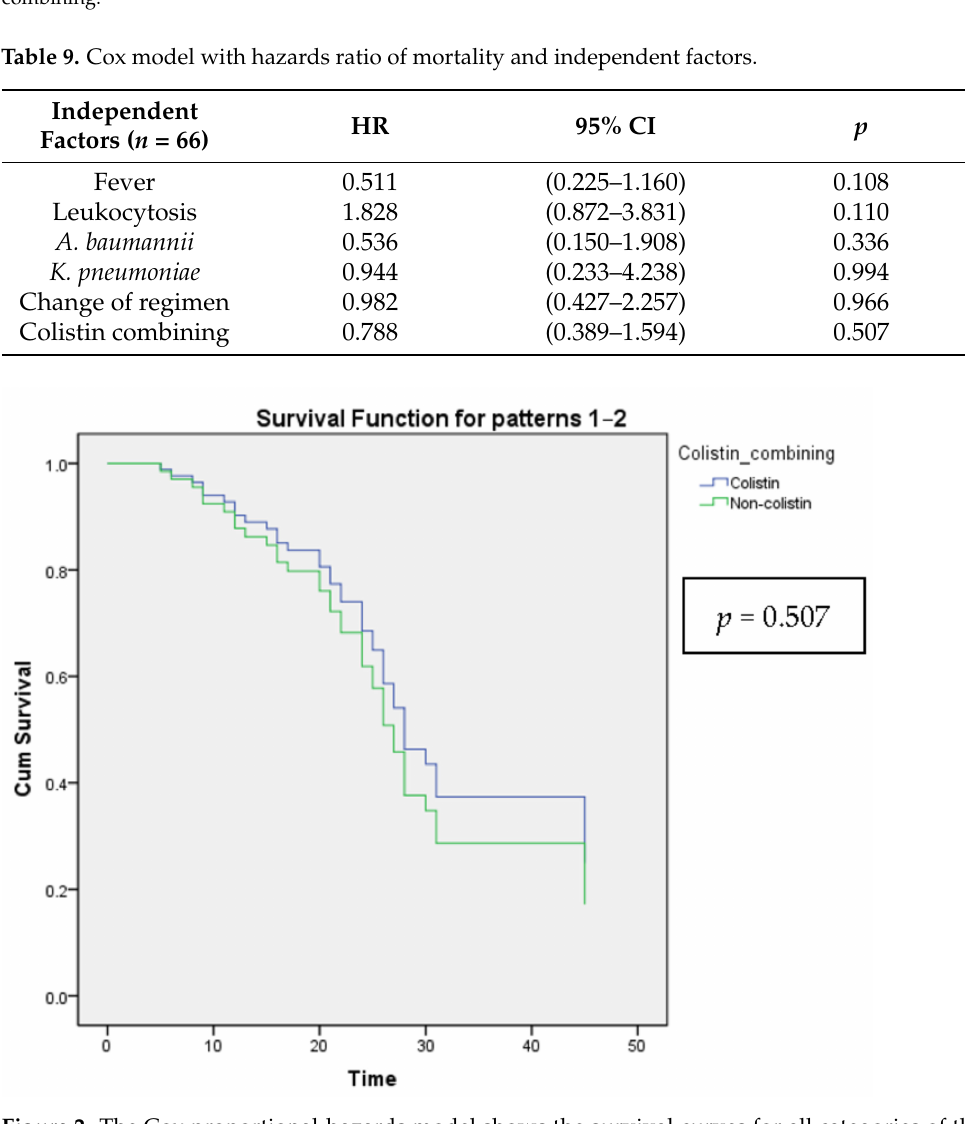
Figure 2. The Cox proportional-hazards model shows the survival curves for all categories of the categorical variable Colistin